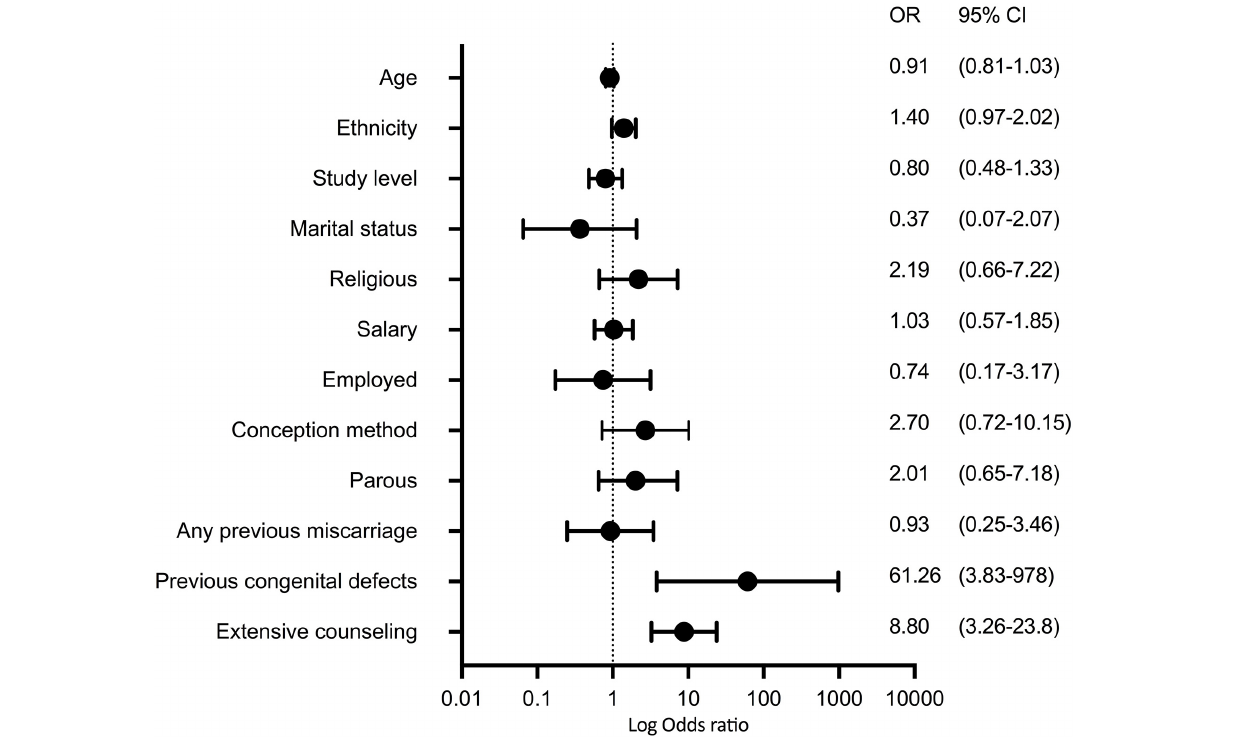
FIGURE 3 | Forest plot showing the odds ratio for the association between the willing to have an invasive procedure as first-line prenatal testing to the demographic characteristics of the included population after adjusting to previous counseling and all variables between each